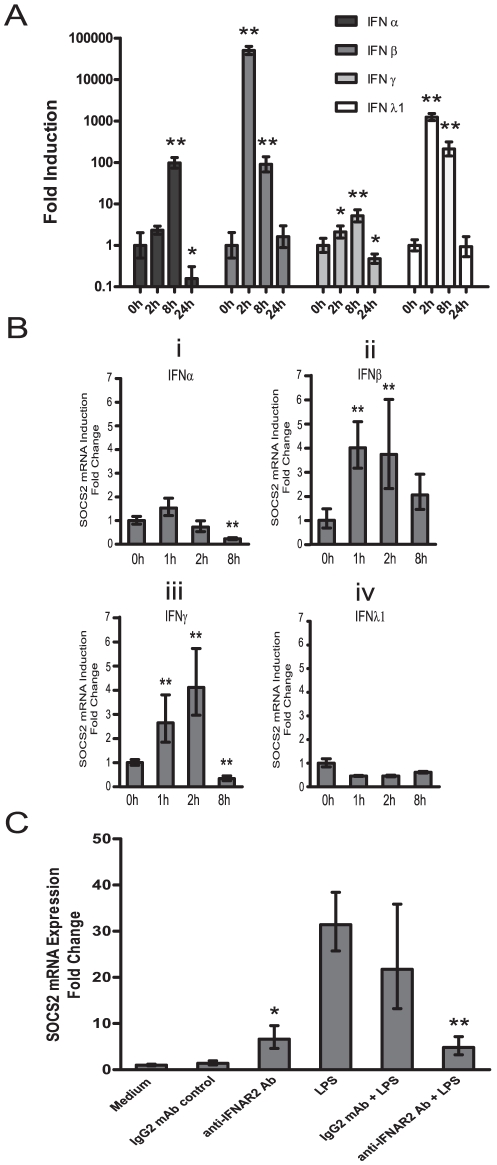
The effect of type I IFNs to SOCS2 mRNA induction in human moDCs.moDCs were exposed to LPS (A) for indicated time periods for mRNA measurement of IFNα, IFNβ, IFNγ and IFNλ1 or incubated with IFNα (Bi), IFNβ (Bii), IFNγ (Biii) and IFNλ1 (Biv) for indicated time periods for SOCS2 mRNA measurement by qRT-PCR. (C) moDCs were pretreated for 30 min with or without 30 ug/ml neutralizing anti-IFNR2 antibodies or IgG2a isotype control mAb and then incubated for 4 h with or without LPS for SOCS2 mRNA measurement by qRT-PCR. Data shown are representative of three independent experiments and expressed as the –fold induction of the gene of interest at different time points compared to time point 0 where the values were set to 1(A–B) or different treatment conditions compared with medium that values were set to 1. Statistical significance of results with anti-IFNAR2 mAb compared with control mAb is indicated (C) (* p<0.05; ** p<0.01).